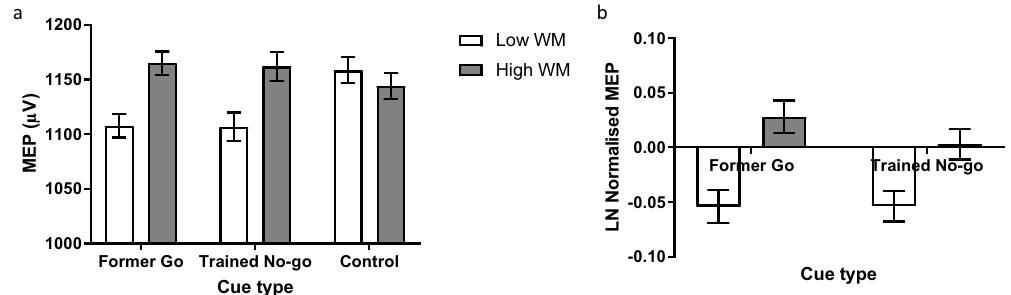
Figure 3. ( a ) Mean raw MEP of data pooled from Experiments 1 and 2 by working memory and cue type. Simple effect of working memory on control cue: t(104) = 0.62, p = 0.539, d = 0.06, BF 01 = 7.68. ( b ) Mean MEP log-normalised to the control cue of data pooled from Experiments 1 and 2 by working memory and cue type. Error bars represent within participant standard errors across working memory conditions separately for each cue type.